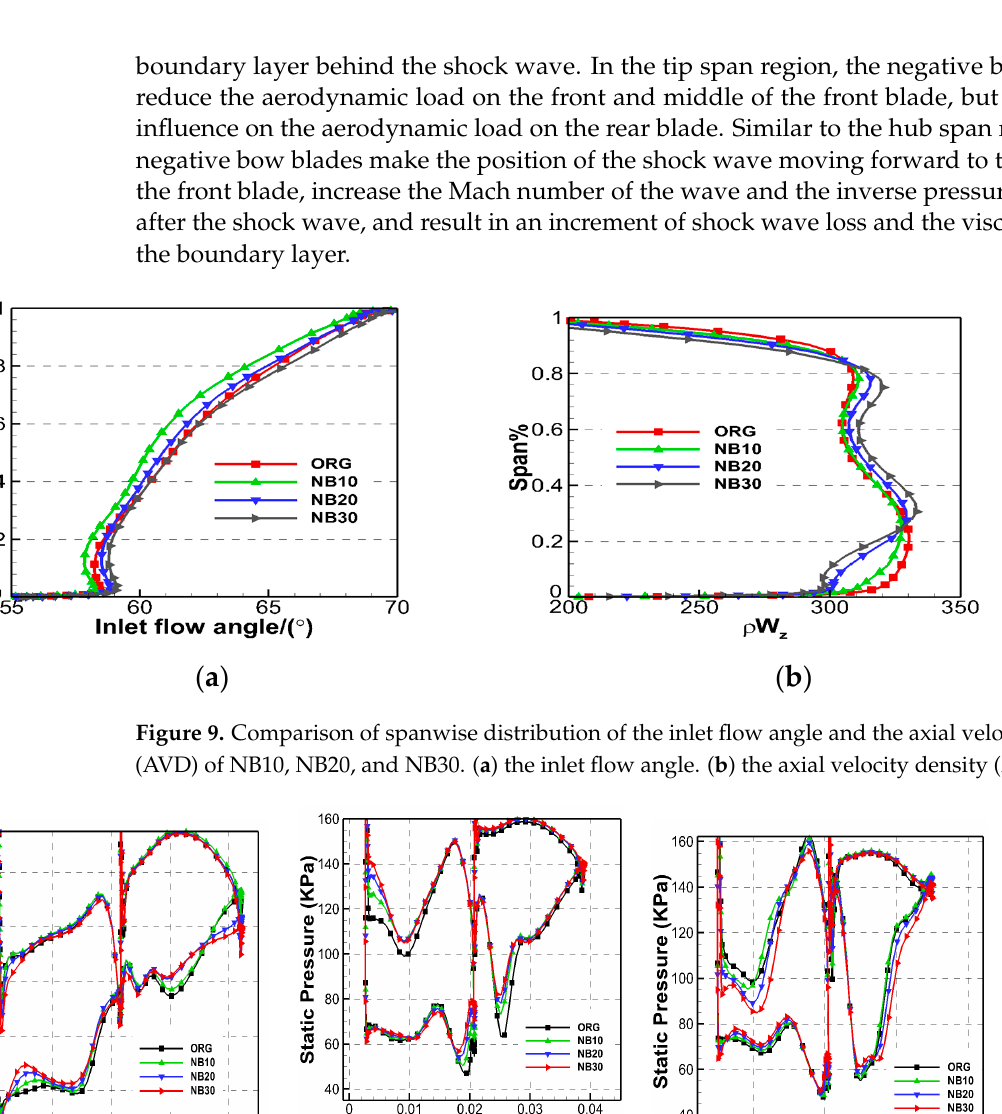
Figure 10. the contrast diagram of surface static pressure distribution at different spans of NB10, NB20, and NB30. ( a ) 10% span. ( b ) 50% span. ( c ) 90% span. NB20, and NB30. ( a ) 10% span. ( b ) 50% span. ( c ) 90%